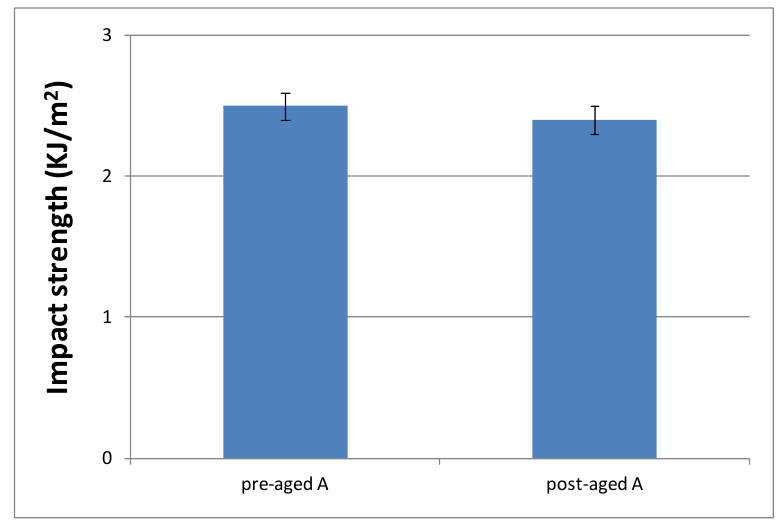
Figure 12. Impact strength values of pre-aged and post-aged materials prepared from A formulation.